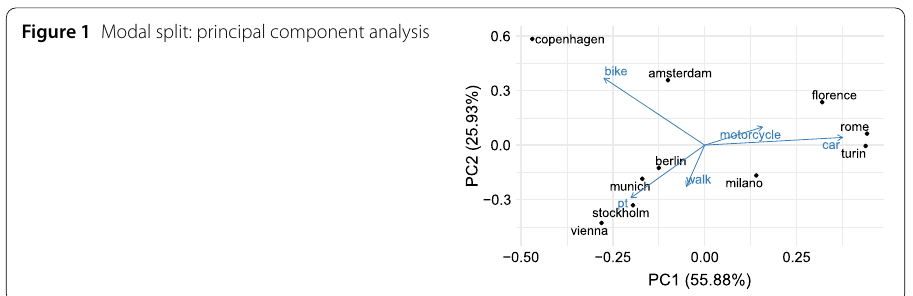
Figure 1 Modal split: principal component analysis